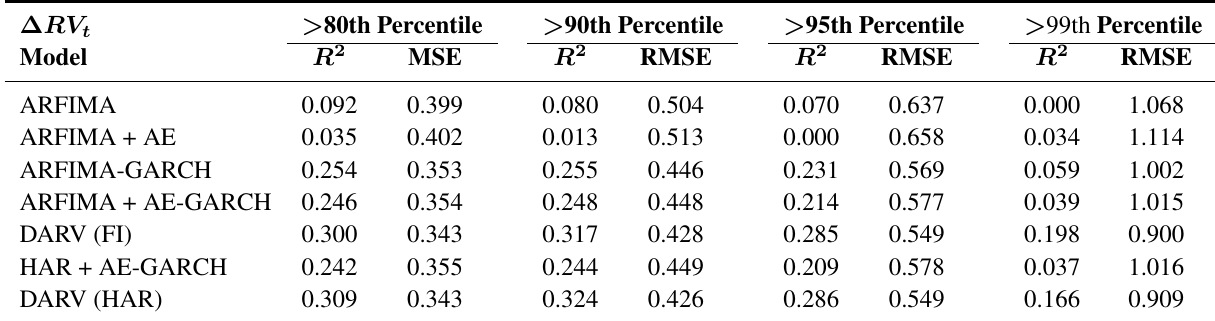
Table 9. Conditional forecasts (S&P 500): large realized volatility changes. ∆ RV t > 80th